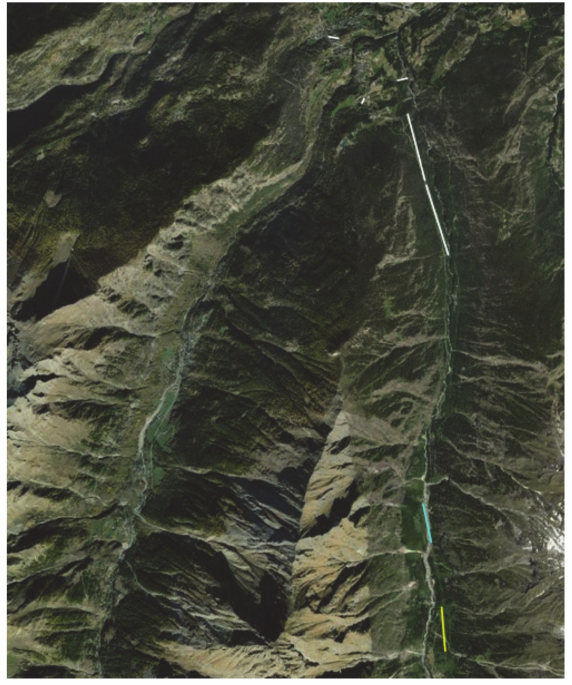
Figure 6. Map of the components with the highest failure probabilities, case M1.1.